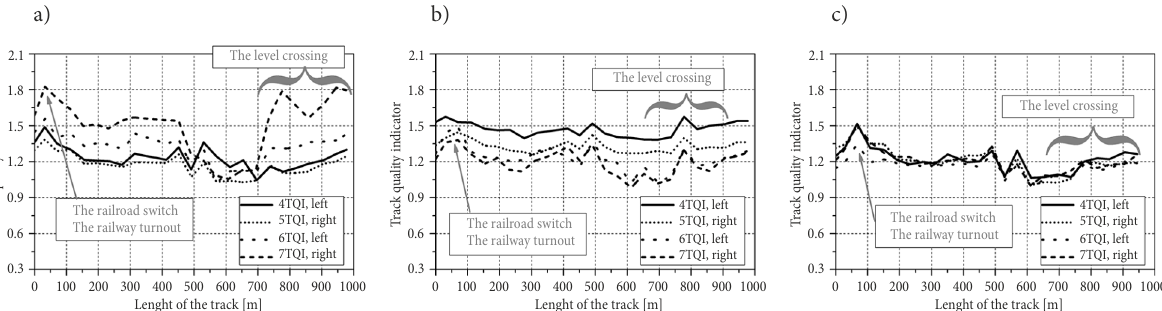
Fig. 10. Track condition chart along Warsaw–Poznan route in the case of B-bogie (a), C-bogie (b), D-bogie (c) – comparing the values of TQI obtained on the right and on the left rails